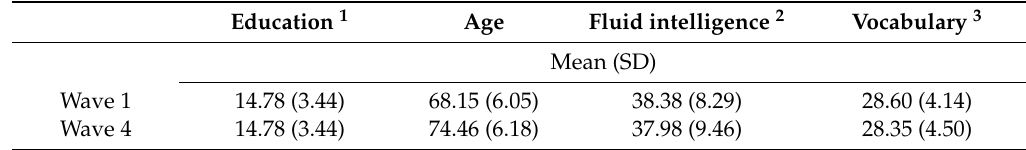
Table 1. Participants’ characteristics ( n =